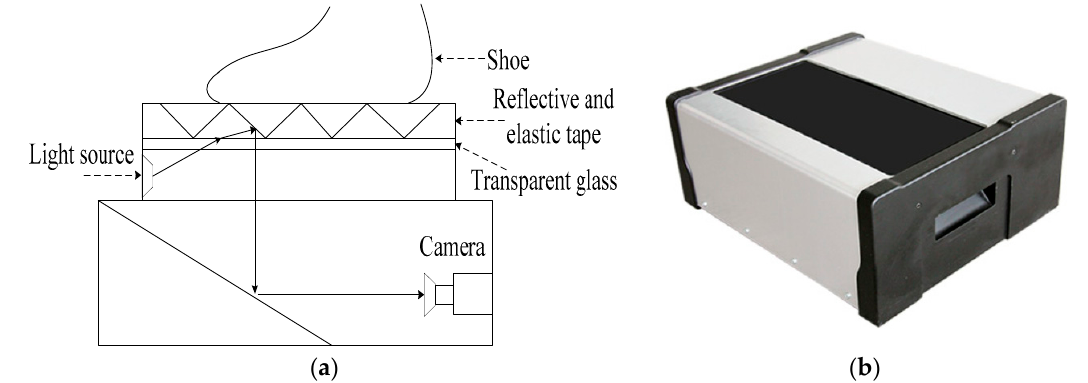
Figure 2. Illustration of the reference shoeprint scanner. ( a ) Structural diagram of the reference shoeprint scanner; ( b ) the real system of the reference shoeprint scanner.